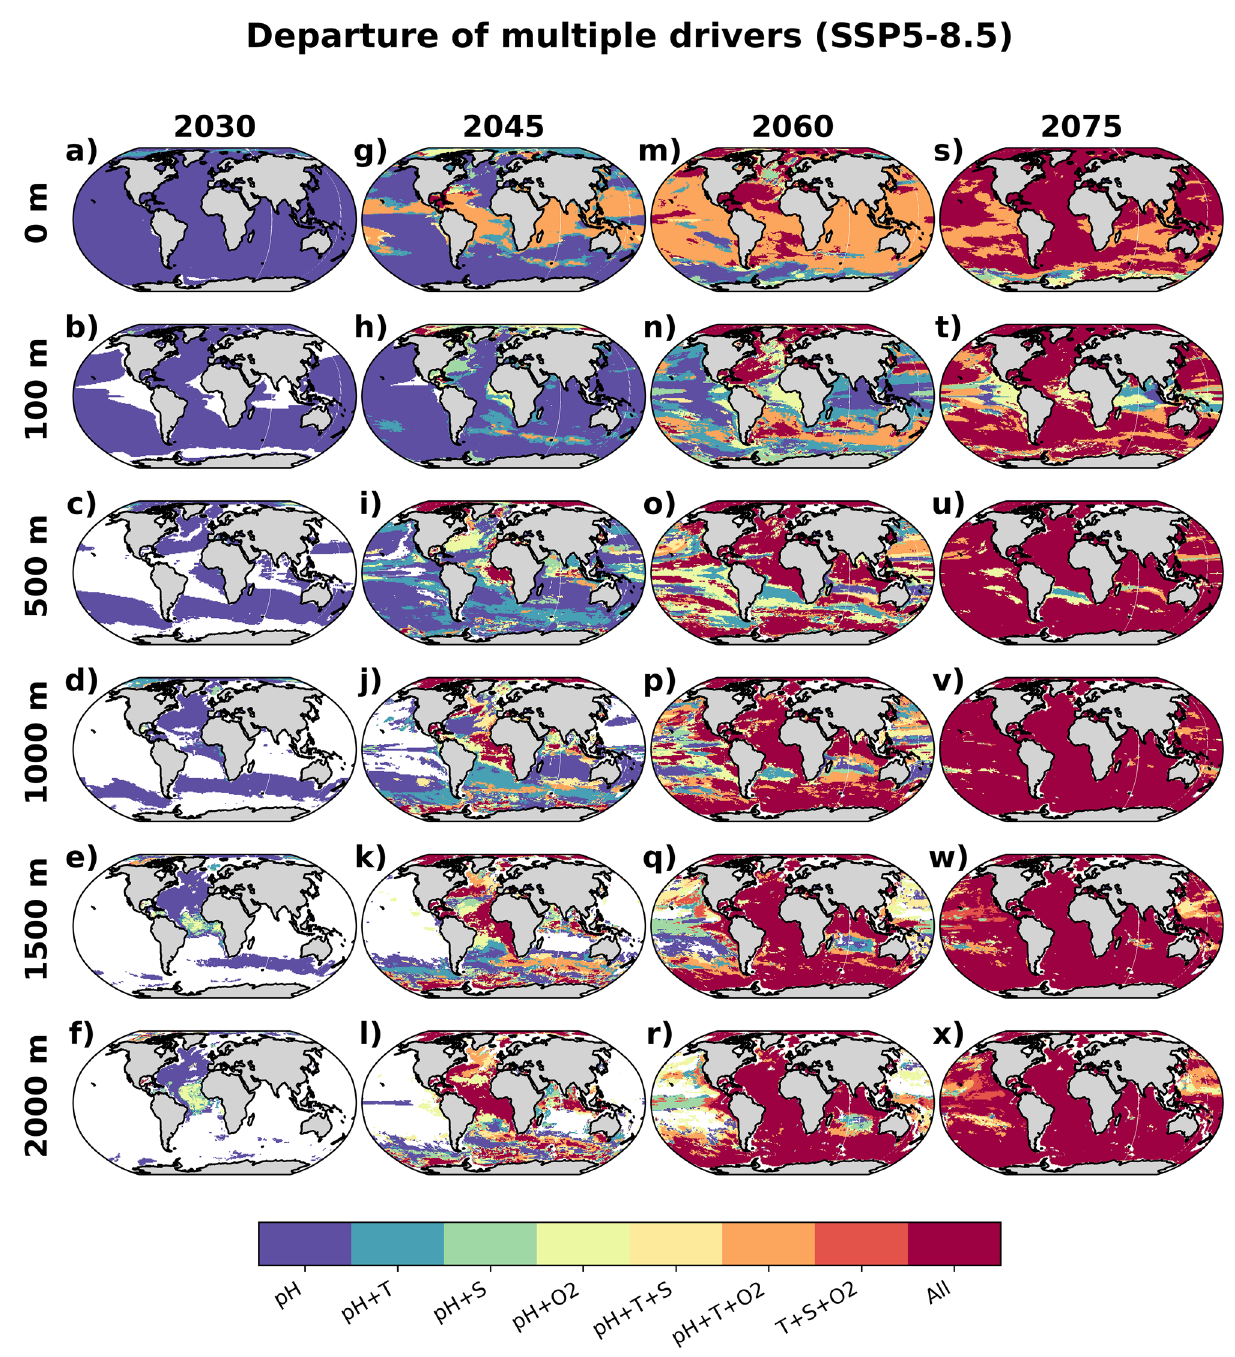
Figure 6. Departure of multiple drivers. Combination of departing variables, based on multi model mean ToD depicted in Fig. 1, in year 2030 ( a – f ), 2045 ( g – l ), 2060 ( m – r ) and 2075 ( s – x ), at ocean surface, 100 m, 500 m, 1000 m, 1500 m and 2000 m depths for SSP5-8.5 scenario. Maps were generated with Python 3.9.16 using Matplotlib v3.6.2 (https:// matpl otlib. org/) and Cartopy v0.21.1 (https:// scito ols. org. uk/ carto